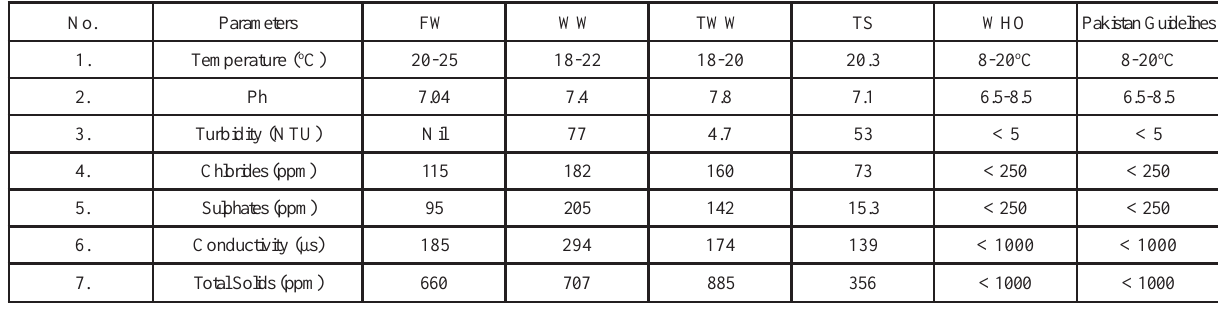
FIG. 4. CONCRETE CYLINDERS READY FOR TESTING (UOL TABLE 2. LABORATORY TESTS OF WATER SPECIMENS